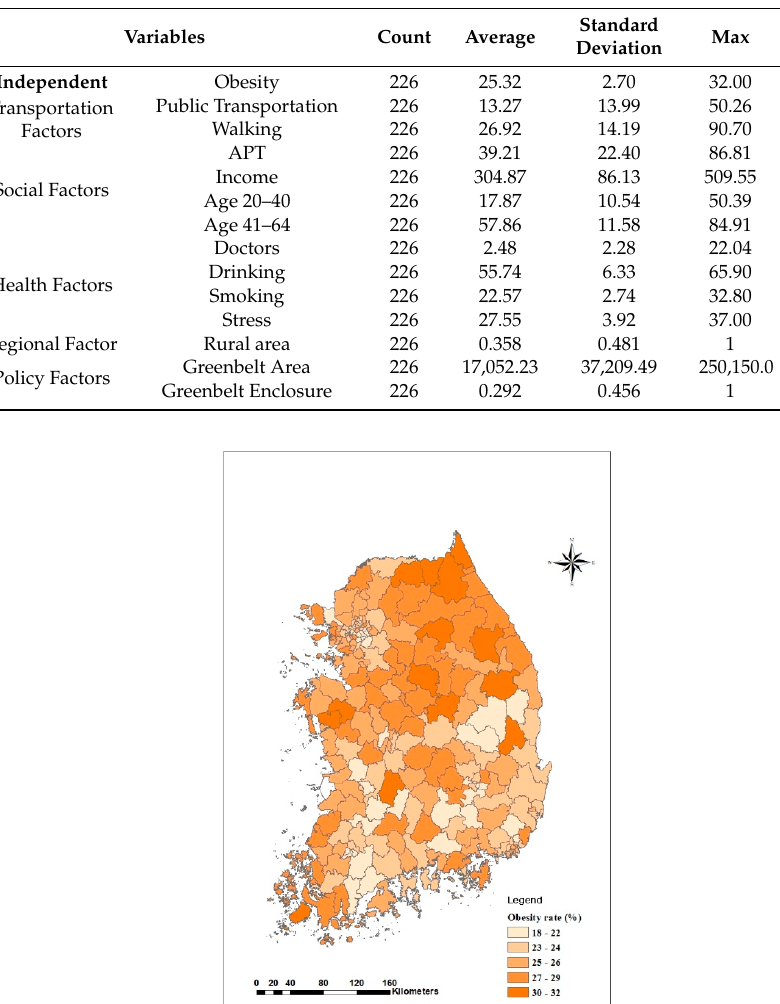
Table 3. Descriptive statistics of variables.